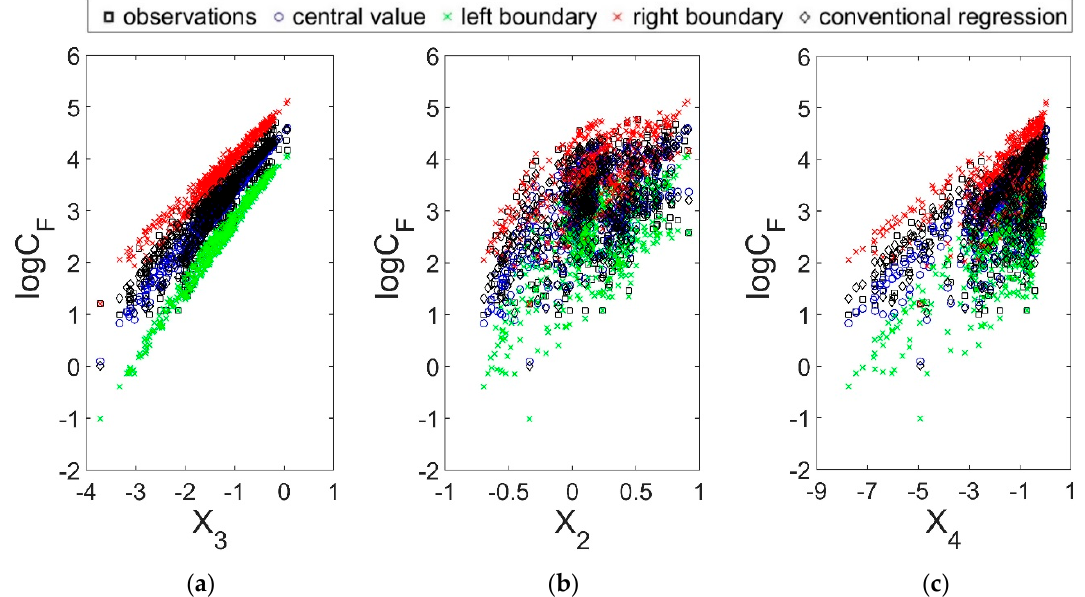
Figure 2. Projection of the achieved fuzzy relation regarding the log of the total sediment concentration with respect to ( a ) X 3 , ( b ) X 2 , ( c ) X 4 .